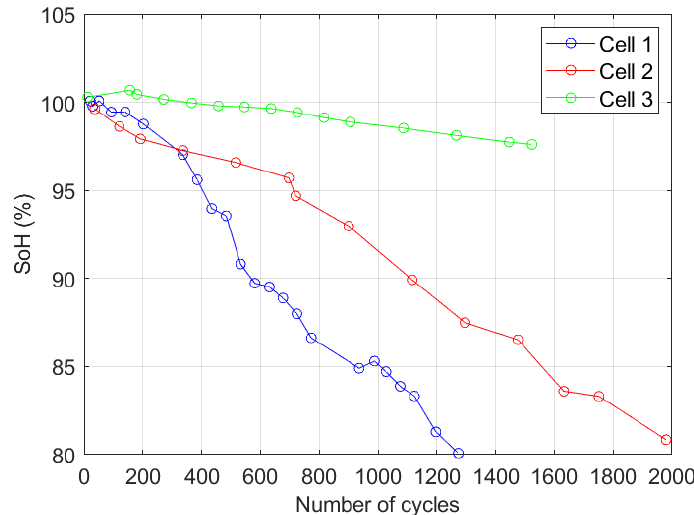
Figure 5. Battery aging under three different conditions. Comparing the degradation trend of Cell One and Cell Three demonstrates elevated temperature accelerates battery aging. Moreover, the lower rate of depth of discharge (DoD), the capacity fade is less.